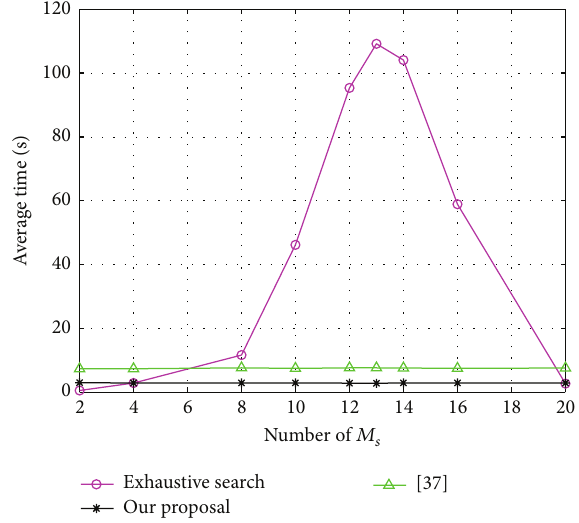
Figure 10: Comparison of optimization processing time of our method with exhaustive search method and [37].